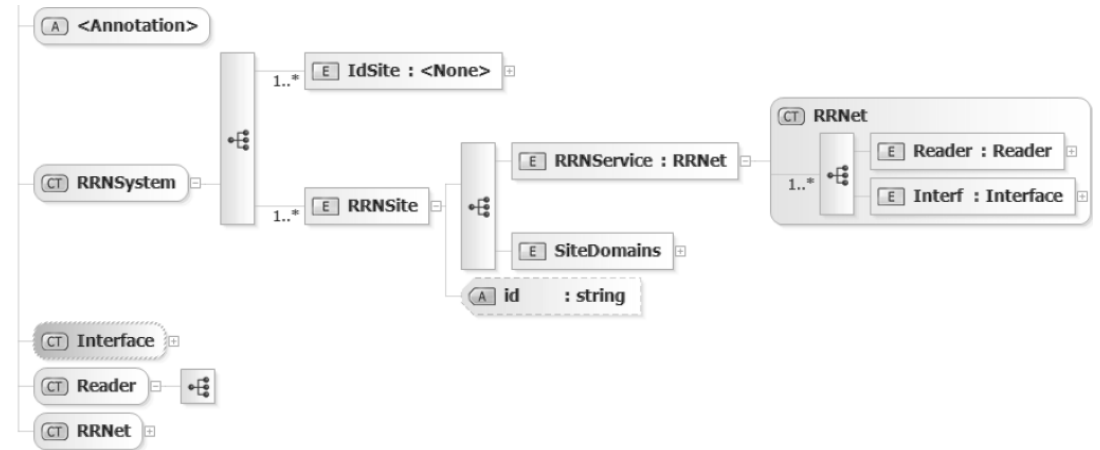
Figure 3. RSN topology